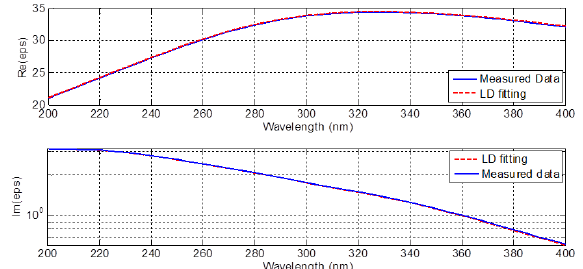
Figure 6. Experimental [9] and fitted Lorentz-Drude model for the real and imaginary parts of the silicon permittivity in the first sub-band where the imaginary part is plotted log